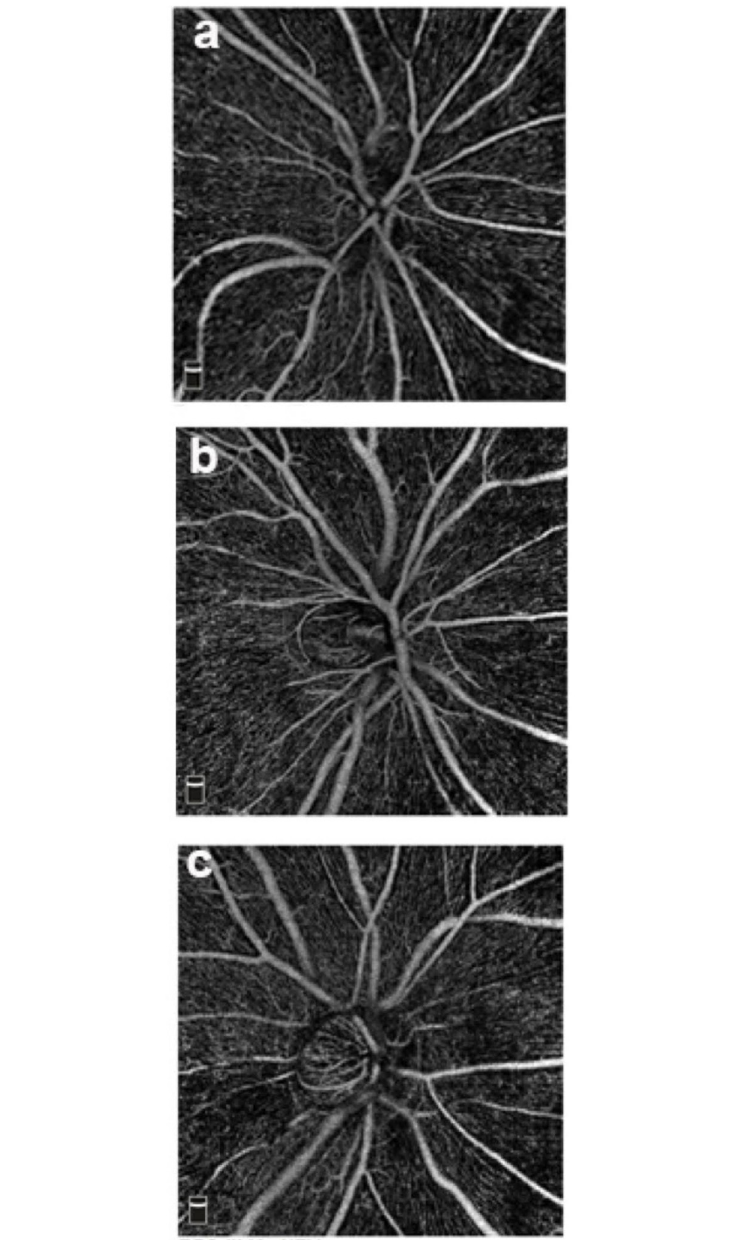
Fig 1. Optical Coherence Tomography Angiography (OCTA) images of the three groups OCTA images in gray scale. a: Control, b: True exfoliation syndrome, c: Pseudoexfoliation syndrome.